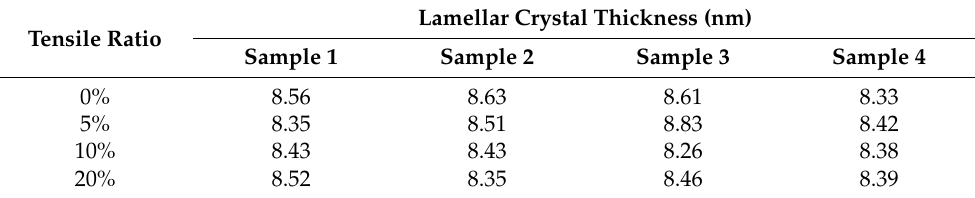
Table 3. Lamellar Crystal Thickness of Each